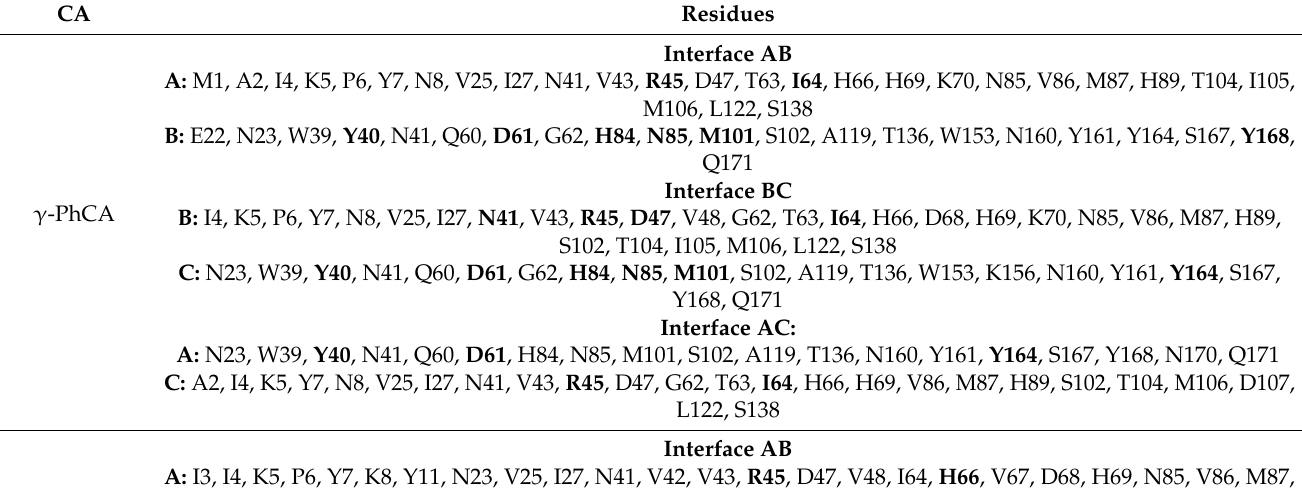
Table 2. Residues common to three programs identified as participating in interface formation. Hotspot residues are in bold. CA Residues